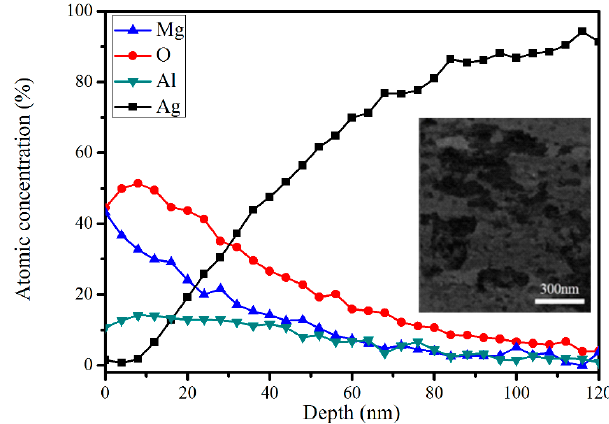
Figure 11. Element depth profiles of the Ag-2Mg-2Al specimen activated at 500 °C for 30 min at P O 2 = 20.0 Pa, after constant electron bombardment for over 200 h. (The inset: scanning electron micrograph of the specimen surface).